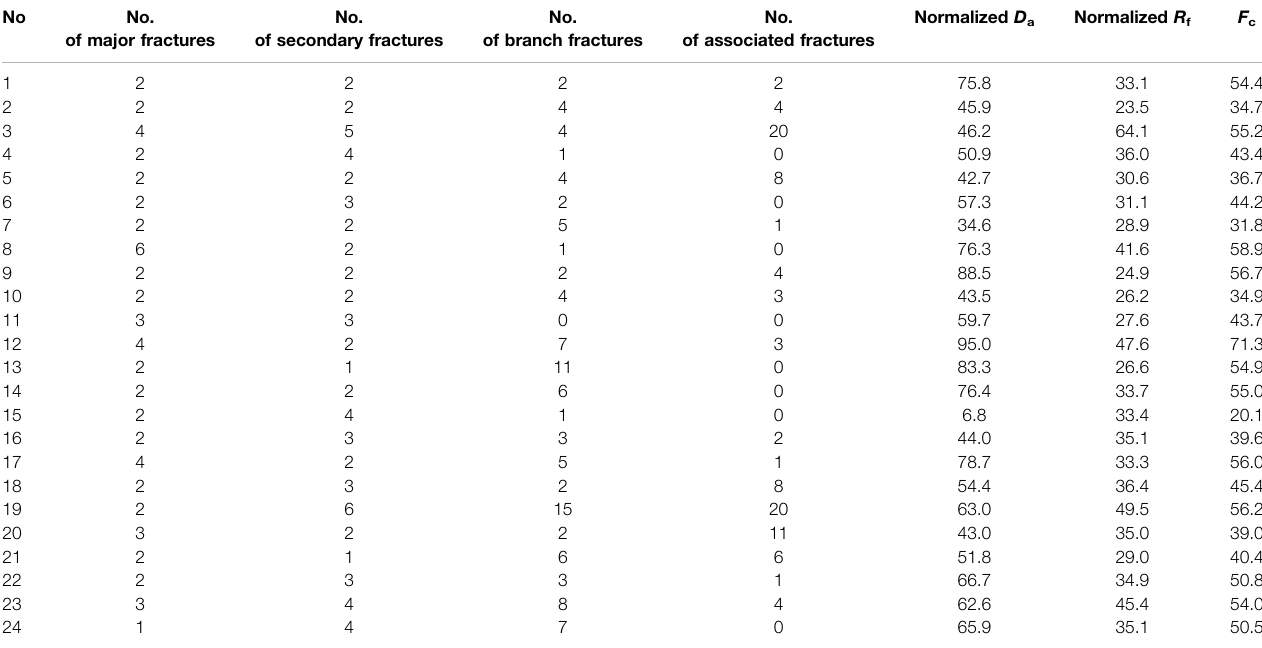
TABLE 2 | Fracturing and fracture analysis results of 24 cores after compression test. No No. No. of major fractures of secondary fractures